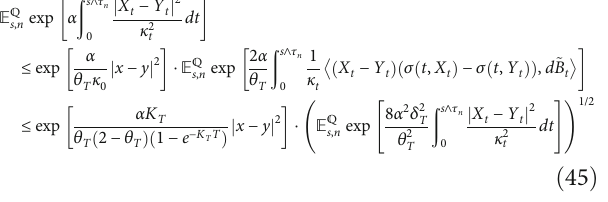
ffiffiffiffiffiffiffiffiffiffiffiffiffiffiffiffiffiffiffiffi r T